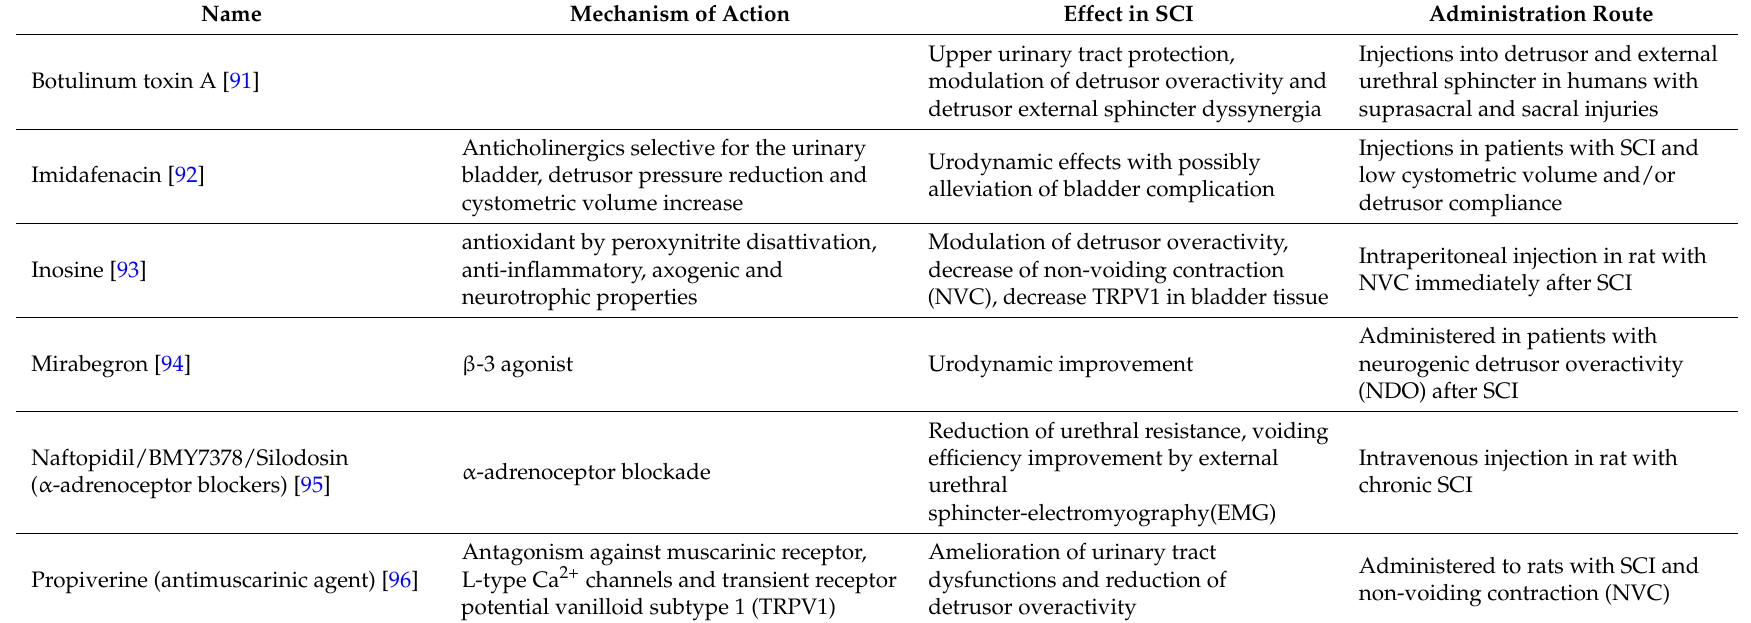
Table 5. Drugs activating the neurogenic detrusor in subject with SCI, reported in the literature over the last two